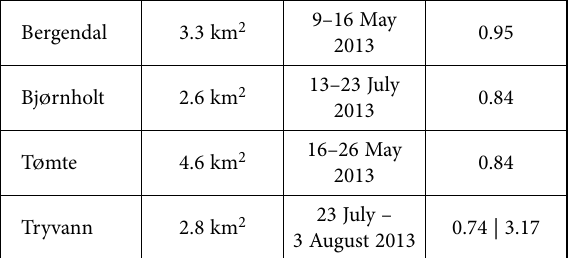
Table 4. The four areas surveyed in 2013. Tryvann is covered by two datasets with different point densities Bergendal